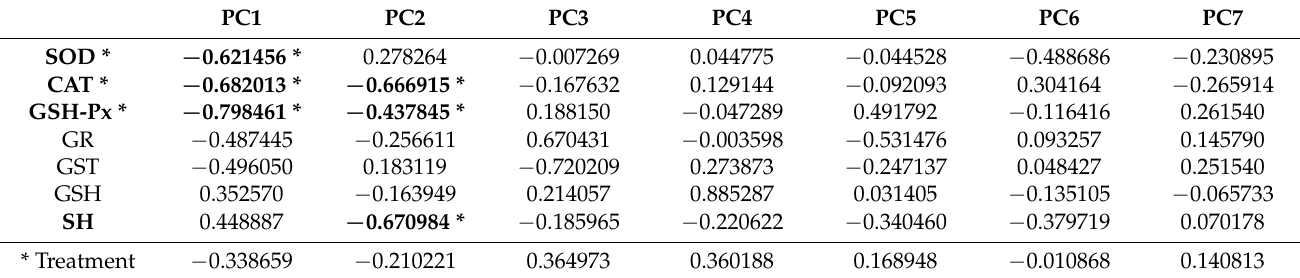
Table 4. Factor coordinates of the variables, based on correlations onto the principal components (PC) in placenta of pregnant Wistar albino rats. (Intact controls, controls, gavaged with bovine serum albumin and vitamin C/day, nano Se-treated animals, gavaged with 0.5 mg Se in the form of SeNPs/kg/body weight/day and sodium selenite (Na-selenite)-treated animals, gavaged with 0.5 mg Se in the form of Na 2 SeO 3 /kg/body weight/day.) The parameters and correlations that contributed most to the separation are marked in bold and marked with asterisk (*).